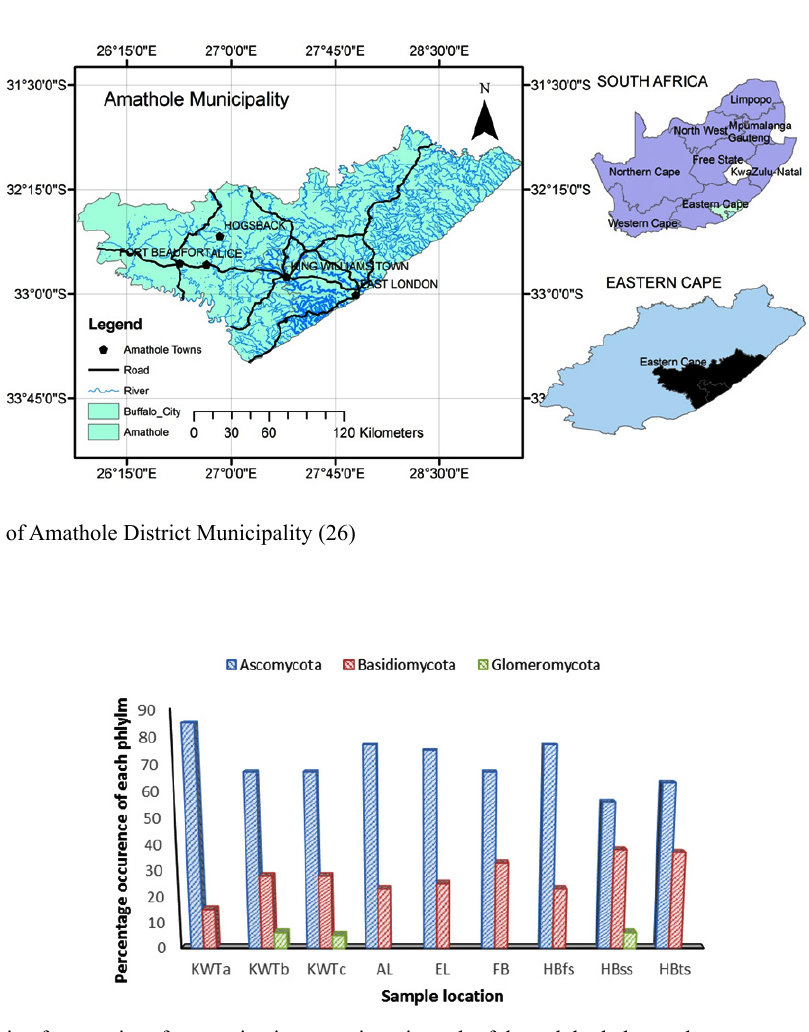
Fig. 2. Relative frequencies of contaminating organisms in each of the polyherbal